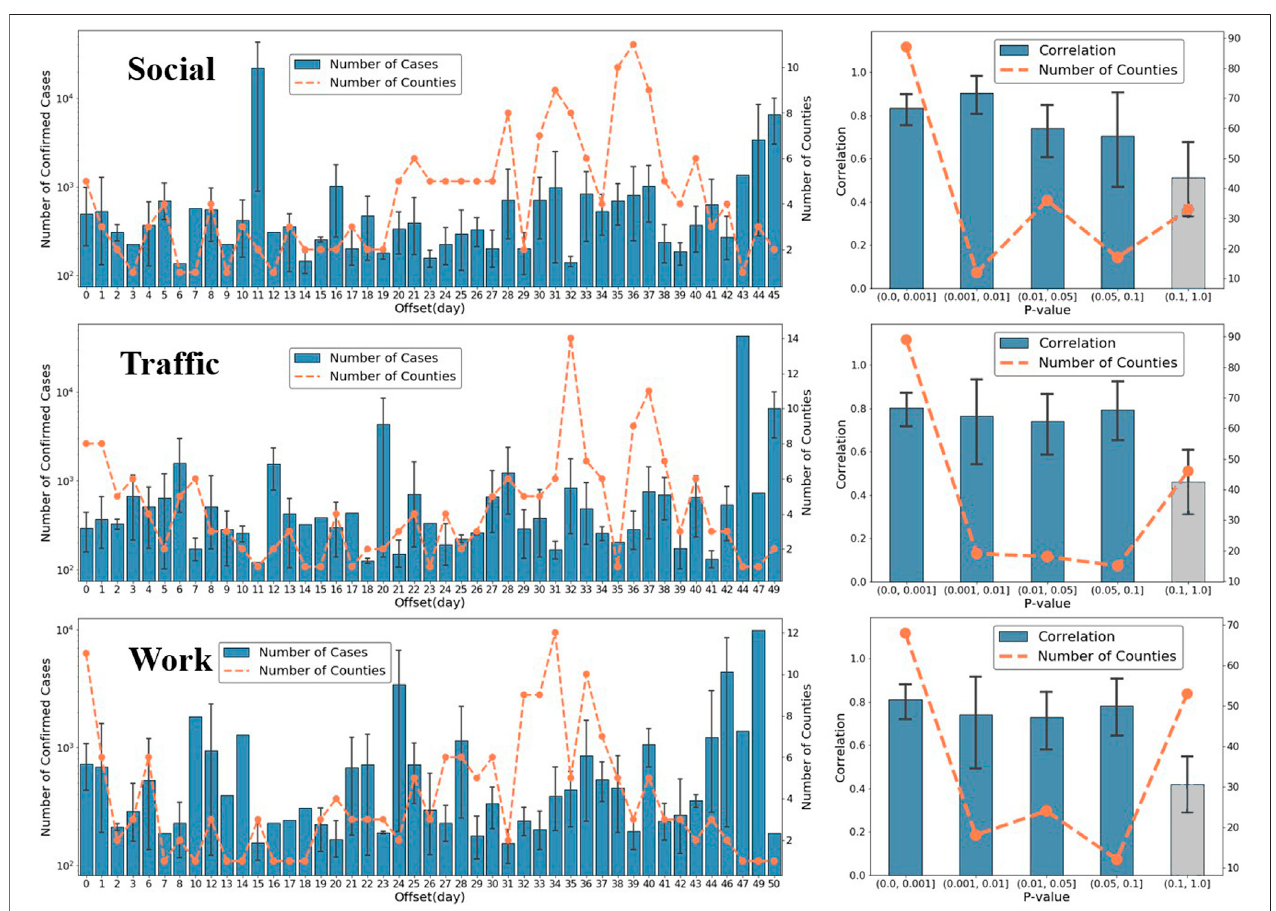
FIGURE 6 | The time-lagged correlation analysis between Venables distance ( D v ) change and reproduction number ( R 0 ). The left column shows the number of cases and the number of counties for different offset days, and the right column shows the correlation index and the number of counties with different p -value intervals. Each row presents one of the three tile activity categories: social, traf fi c, and work.